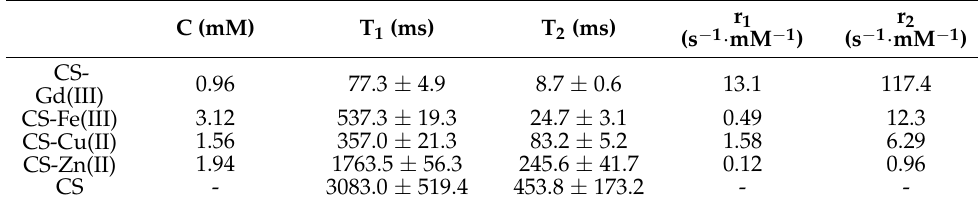
Table 2. List of T 1 , 2 values for CS–metal and CS microgel suspensions obtained from mono expo- nential fits in Figure 7 and proton relaxivities r 1,2 calculated according to Equation (3). (C: metal ion